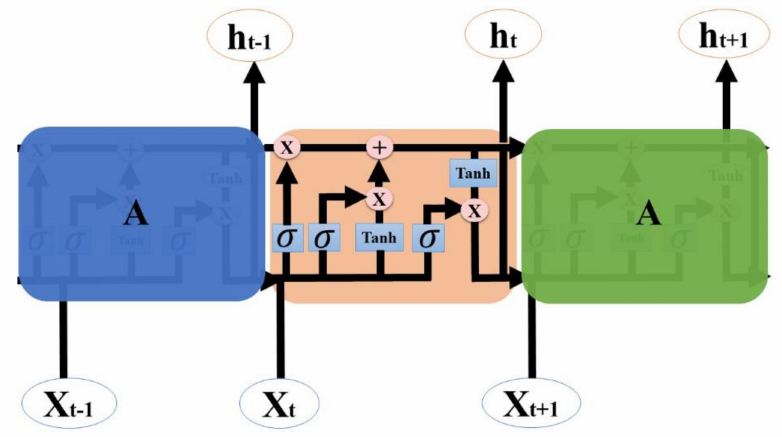
Figure 4. Structure of LSTM.